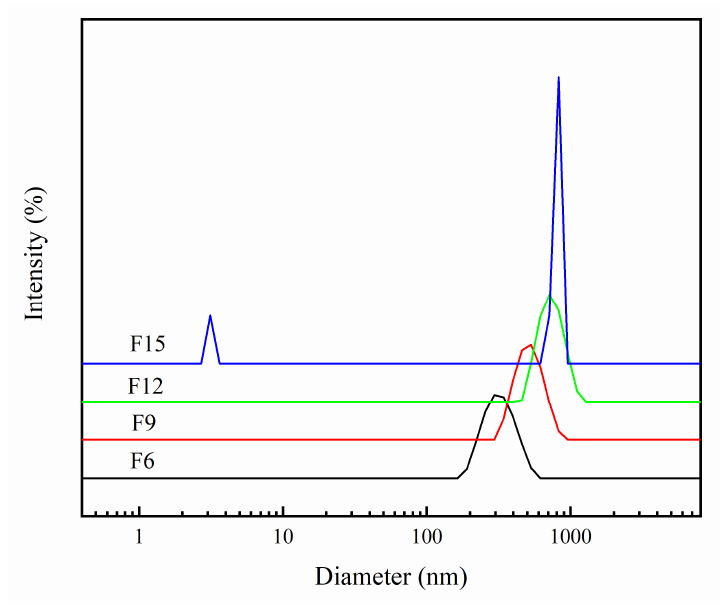
Figure 9. Particle size distribution map of FX.